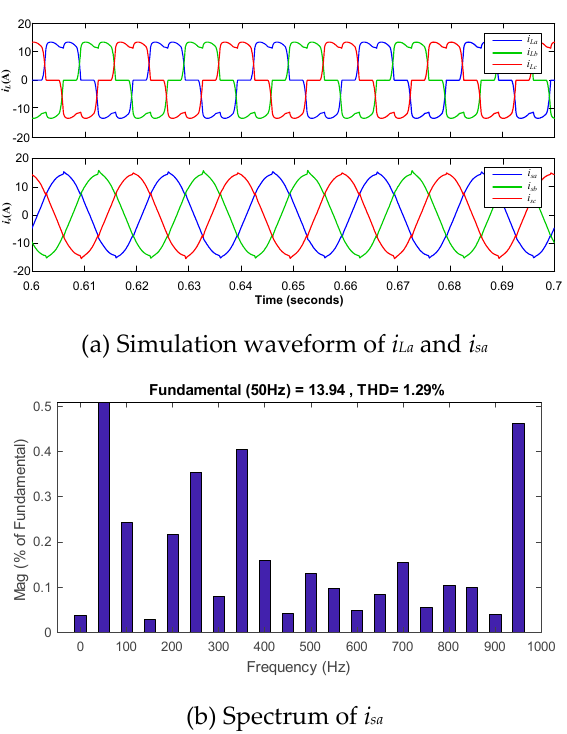
Figure 6. Simulation waveform of SAPF based on multi-resonance sliding mode controller (MRSMC) in steady state. Energies 2020 , 13 , x FOR PEER REVIEW